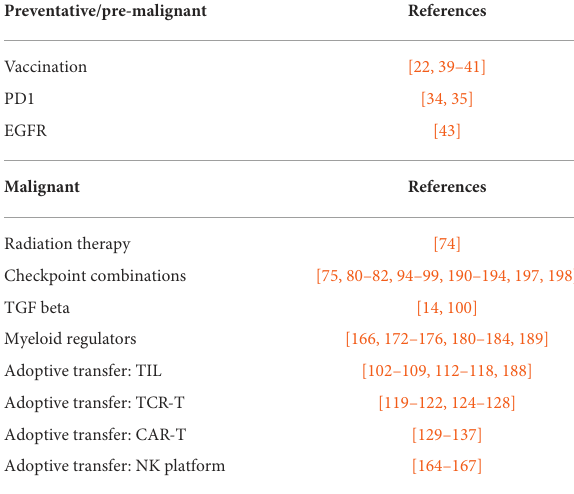
TABLE 1 Immunotherapy interventions